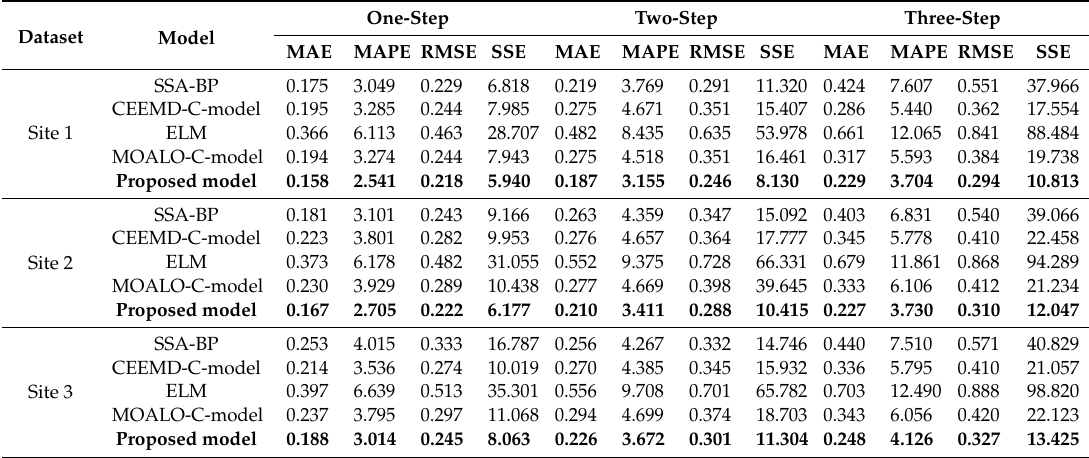
Table 14. Comparison of forecasting evaluation metrics based on the testing set with two days length for the proposed strategy with some good performing models.